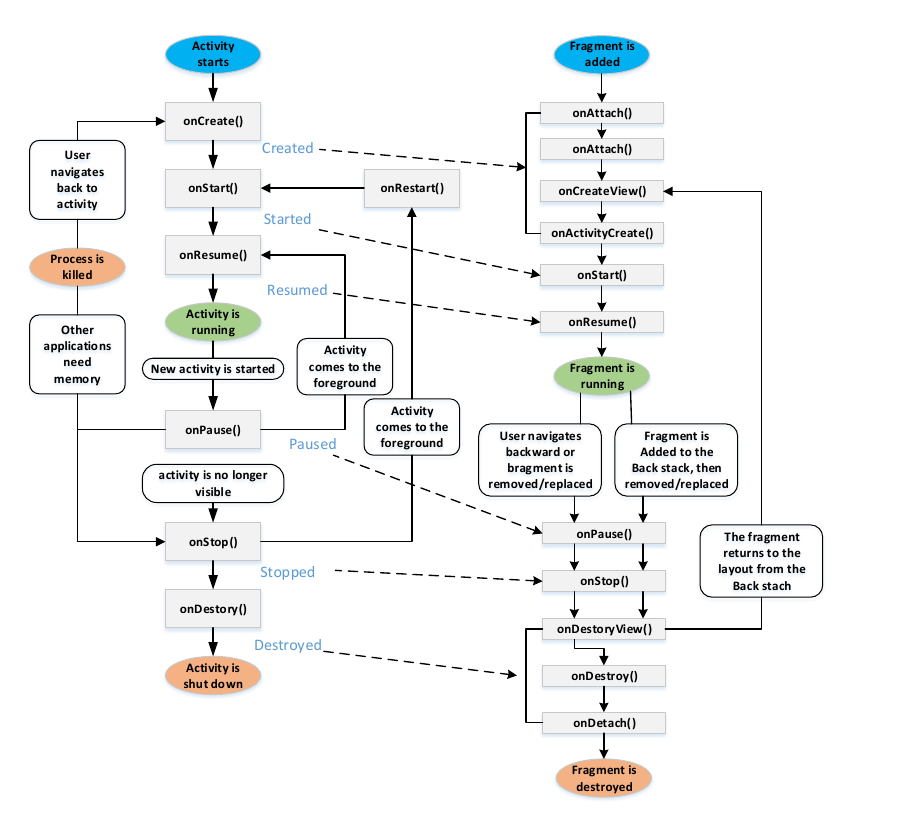
Figure 1. Fragment